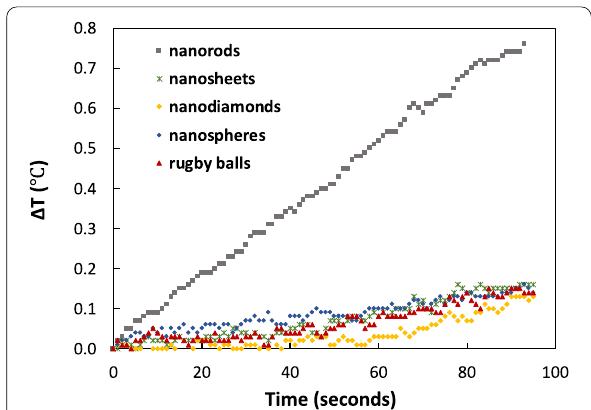
Fig. 5 Temperature profiles for the hematite shapes (4 mg/mL). AMF heating conditions: field frequency kA/m, average initial solution temperature